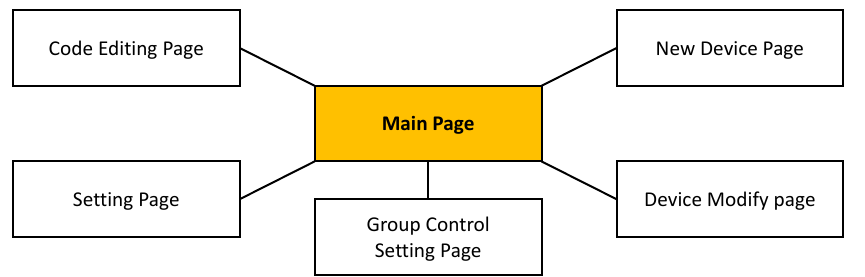
Figure 4. Web user interface